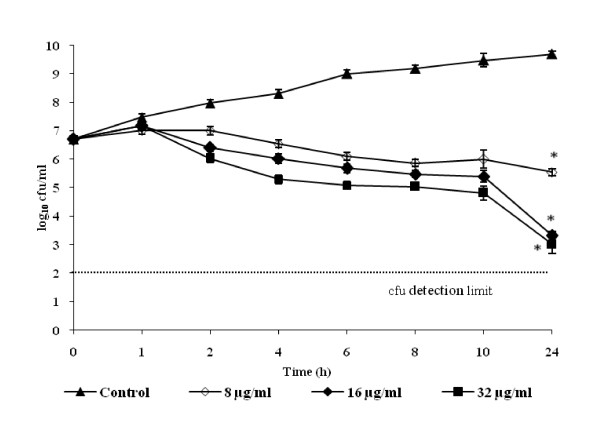
Effect of AKBA at different concentrations (8, 16 and 32 μg/ml) on the cell viabilty of S. aureus ATCC 29213. S. aureus cells without AKBA served as control. The effect of AKBA was observed bacteriostatic at all tested concentrations when compared with non treated control (P < 0.05) over a period of 24 h study. Each time point represents the mean log10 standard deviations (±SD) of three different experiments performed in duplicate. *, P < 0.05; (Student's t test).